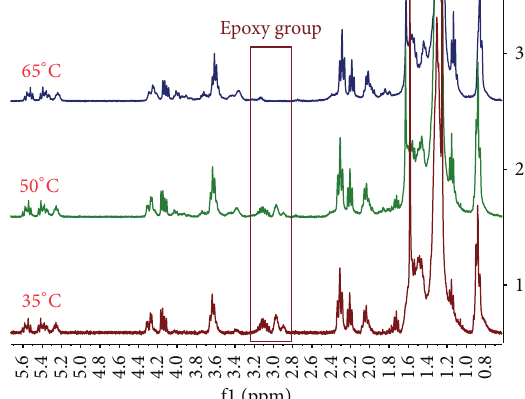
Figure 7: 1 H-NMR spectrum of polyol from ESBO and solvent.